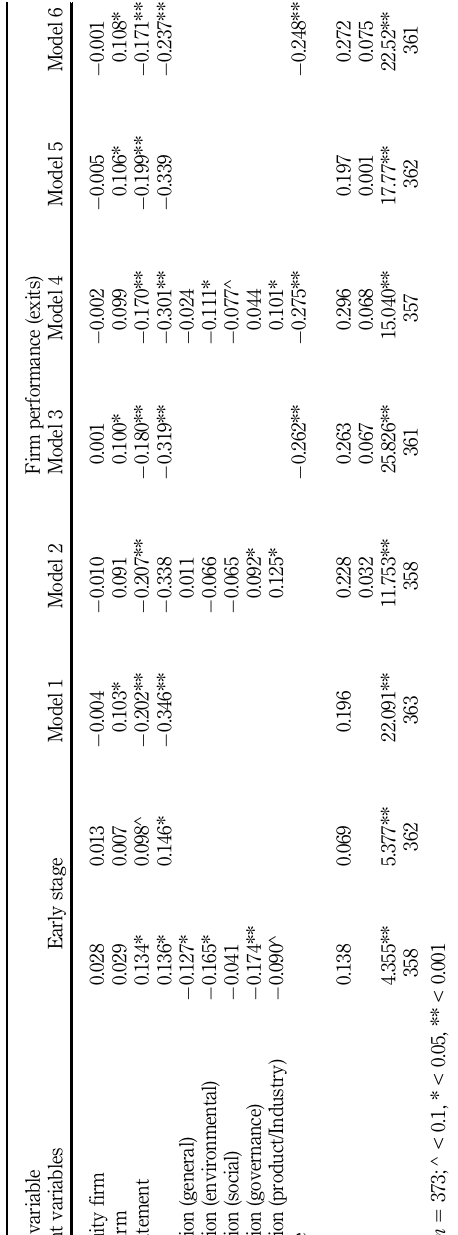
Table 3. Results of the standardized regression analysis for the mediated effects